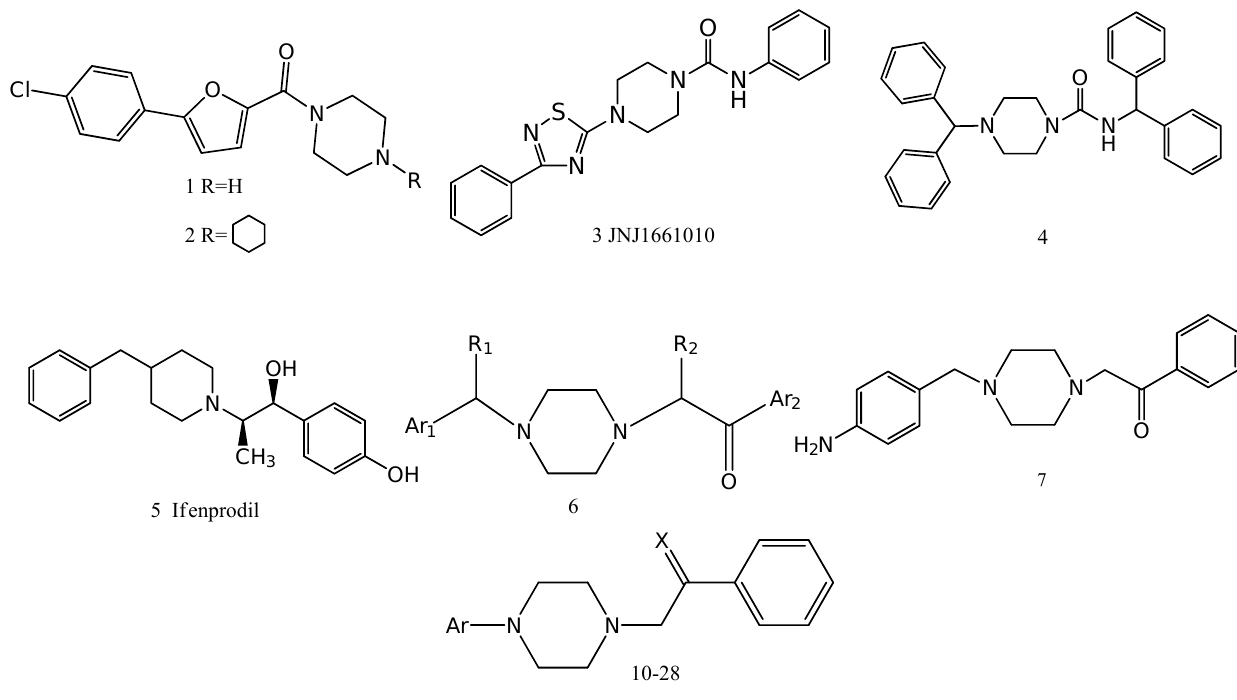
Figure 1. Title and reference